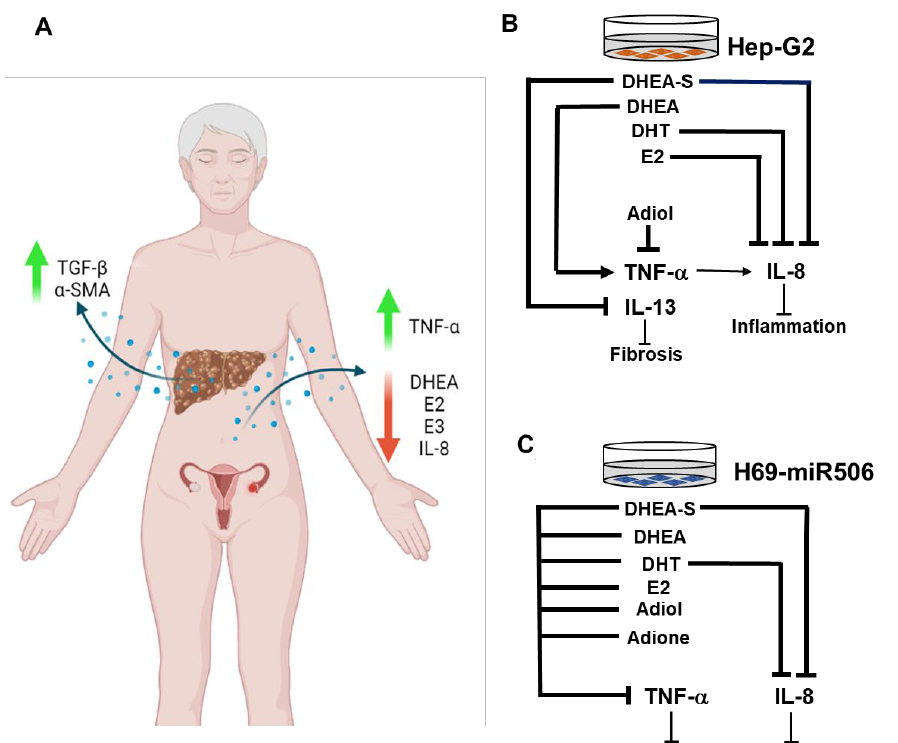
Figure 6. The potential involvement of DHEA and its metabolites in modulation of inflammation and fibrosis. The level of steroid hormones (DHEA, E2, and E3) and cytokines (IL-8 and TNF- α) in the serum of PBC patients at an age of diagnosis above 65 ( A ). The expression of TGF- β and α -SMA in cirrhotic PBC livers ( A ). The effect of DHEA and its metabolites (DHEA-S, E2, and DHT) on inflammation and fibrosis in hepatocytes (Hep-G2) ( B ) and PBC-like cholangiocytes with overexpression of miR-506 (H69-miR506) ( C ), (see the discussion section for more details). Table 2. Baseline clinical characteristics of analyzed PBC patients (mean ±